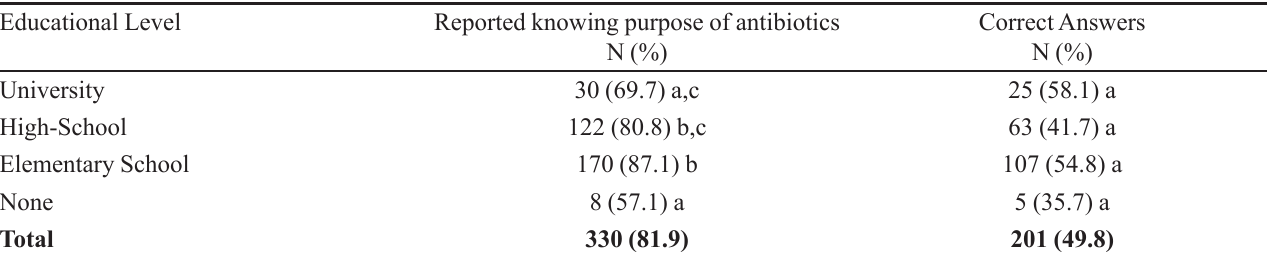
TABLE II – Correct answers regarding use of antibiotics.